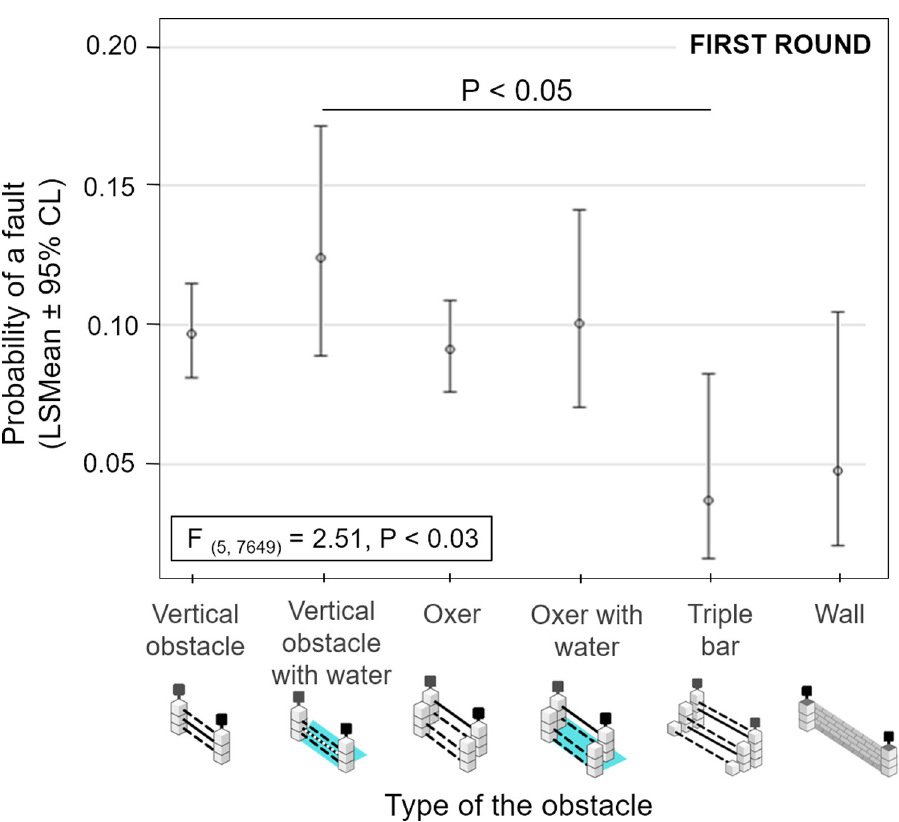
Fig 2. Predicted probability of a fault on different types of obstacles. Predicted probability of a fault on different types of obstacles in the first round (mean values ± 95% confidence limit, GzLMM, PROC GLIMMIX, SAS).